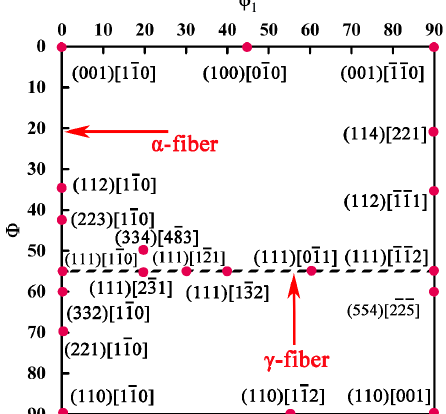
Figure 7. φ 2 = 45° ODF sections of the ideal body-centered cubic rolling and recrystallization fibers. Figure 7. ϕ 2 = 45 ◦ ODF sections of the ideal body-centered cubic rolling and recrystallization The properties of ferritic stainless steel are closely related to the recrystallization tex- ture, and the cold-rolling textures have a great influence on the recrystallization texture [22]. The aggregation state of the grain orientation can be seen from the ODF. The ODFs ( φ 2 = 45° sections) of specimens at 50% and 90% deformation with different annealing temperatures are reproduced in Figure 8a–h, respectively. The cold-rolling texture of fer- ritic stainless steels is mainly composed of the weak γ -fiber and strong α -fiber compo-